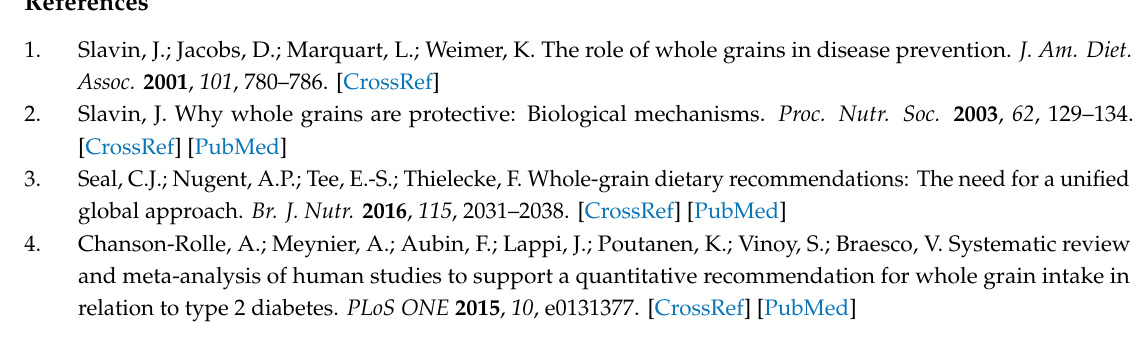
Table S1. Framework of concepts used as guidance and prompts during the interviews. Concepts / ideas inspired from literature on whole grain, adolescent diet, and adolescent lifestyle